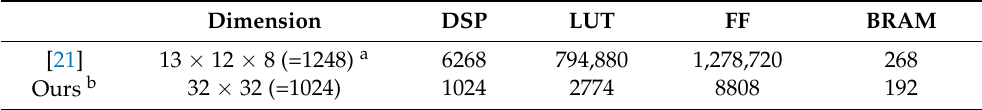
Table 3. Resources usage comparison (for matrix multiplication task). Dimension DSP LUT FF BRAM [21] 13 × 12 × 8 (=1248) a 6268 794,880 1,278,720 268 Ours b 32 × 32 (=1024) 1024 2774 8808